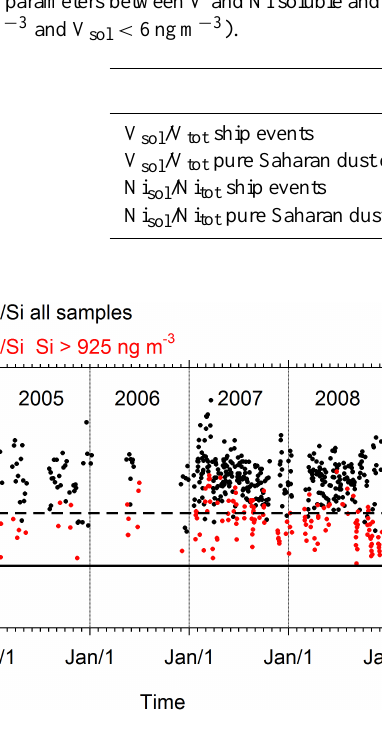
Fig. 1. Temporal evolution of Ni tot /Si tot in PM 10 samples col- lected at Lampedusa island. Black line represent the Ni/Si mean ratio in upper continental crust (Henderson and Henderson, 2009), dashed line represent the threshold values for sharing samples en- riched (one order of magnitude higher than black line). Red dots are samples with high dust content (Si > 925ngm − 3 ).